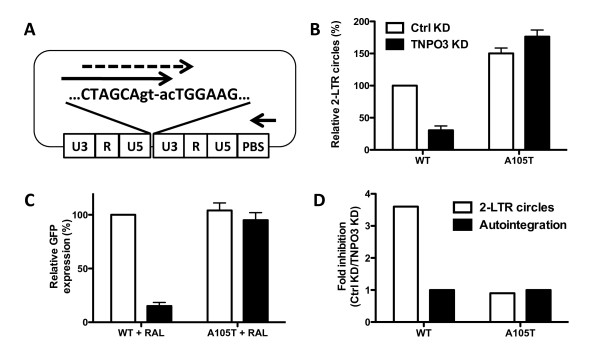
PCR with oligonucleotides that overlap the circle junction demonstrate decreased levels of HIV-1 2-LTR circles when TNPO3 is depleted. (A) Schematic representation of 2-LTR circle qPCR in which the forward primer overlaps with the circle junction. In particular the forward primers anneal with the 3′LTR and either 2 (solid arrow, Junct2 fwd) or 4 (dashed arrow, Junct4 fwd) nucleotides of the 5′LTR. (B) Quantification of 2-LTR circle PCR products with forward primer overlapping 2 nucleotides of the 5′LTR (as indicated in G, Junct2 fwd), 24 hours after infection of WT and A105T CA mutant viruses on control (Ctrl) or TNPO3 KD TZM-bl cells. The PCR products were detected using Sybr green. (C) Env- HIV-1 viruses carrying either WT or A105T mutated CA and encoding GFP-reporter (HIV-1NL4-3GFP) were used to challenge control (Ctrl) and TNPO3 KD cells treated with 10 μM raltegravir. At 48 hrs the percent GFP+ cells was determined by flow cytometry as an indication of GFP expression from unintegrated viruses. (D) 2-LTR circles and autointegration events quantified by high-throughput sequencing of low-molecular weight DNA extracted from control (Ctrl) or TNPO3 KD cells, 24 hrs after transduction with WT or A105T CA mutant viruses. Ratios between the levels in control (Ctrl) KD versus TNPO3 KD are plotted. Data represent one of at least three independent experiments. Error bars represent ± SEM (n = 3).